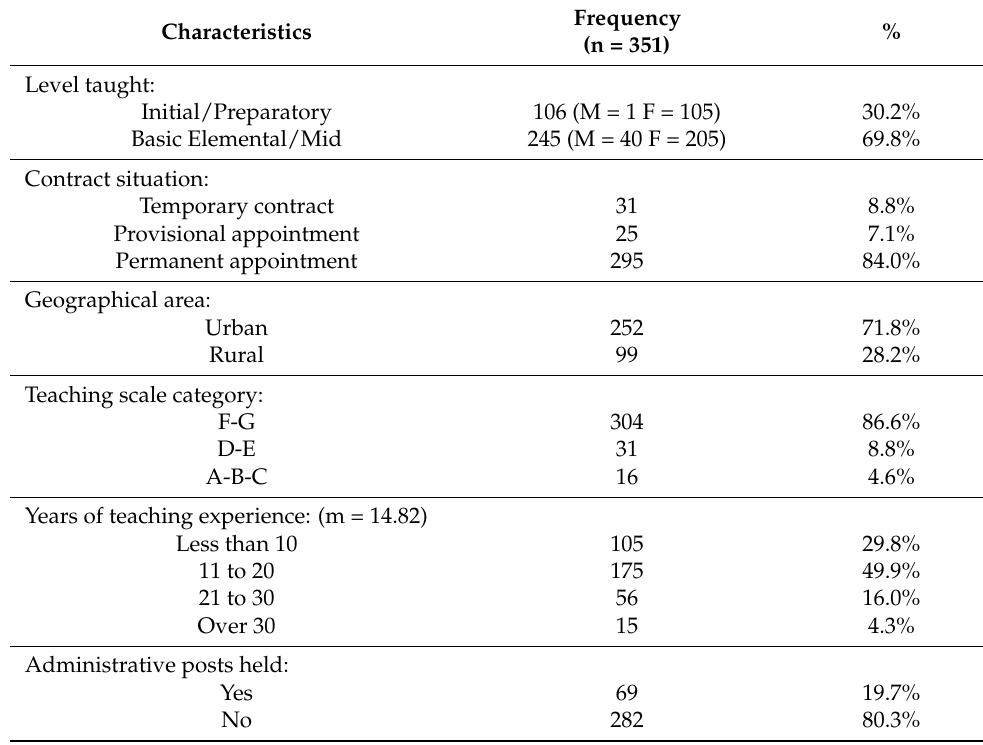
Table 2. Career profile of the sample of infant and primary education